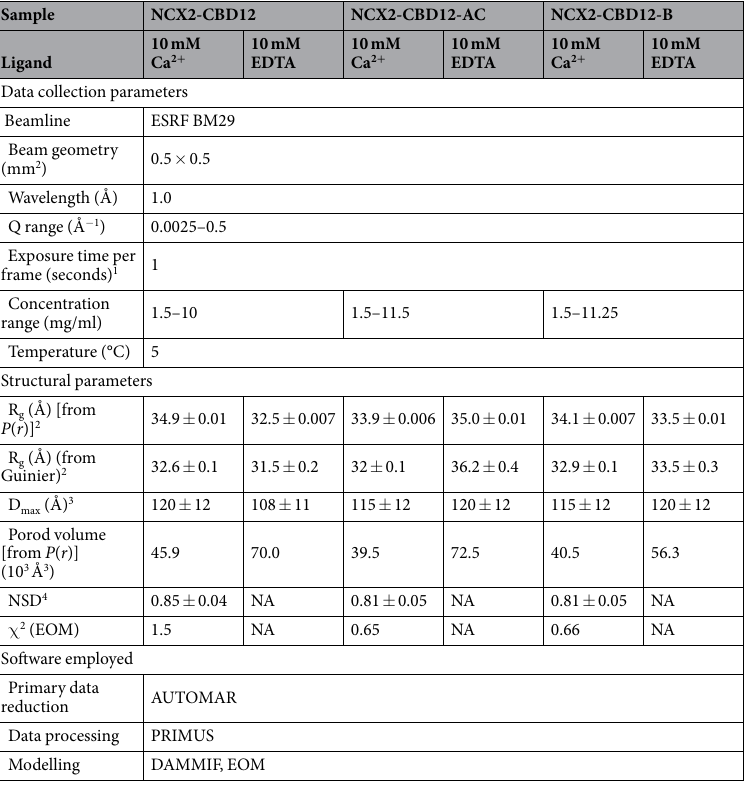
Table 1. . 1 Ten frames were measured for each sample. 2 ± S.E. 3 ± 10% (estimated range). 4 NSD, normalized shape discrepancy for DAMMIF